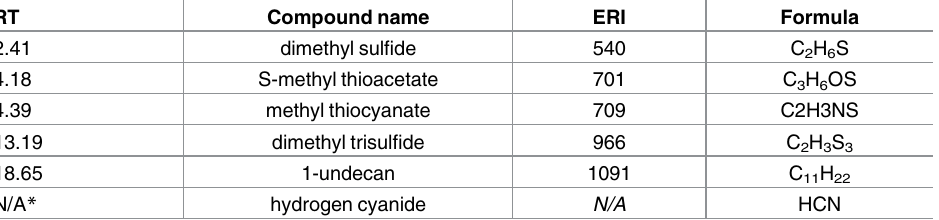
Table 2. Volatile compounds identified in the headspace P . donghuensis P482 wt not present in the KN3318 gacA mutant culture.